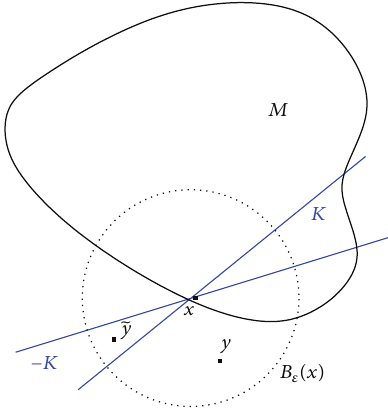
Figure 5: Cone monotone functions have no local extrema.